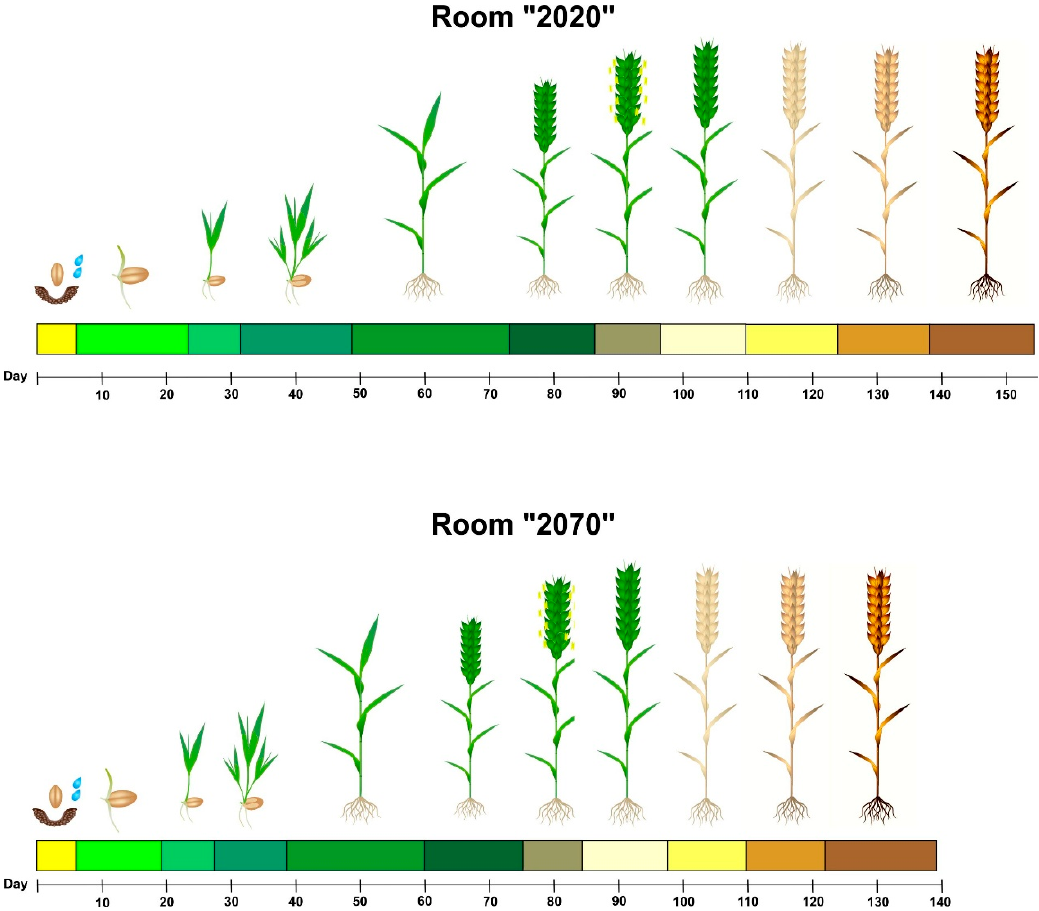
Figure 1. Durum wheat life cycle in the different environmental conditions of rooms “2020” and “2070”. The pictures represent the developmental stages (Planting, Emergence, II leaf, Tillering, Booting, Inflorescence emergence, Flowering, Grain filling “milk stage”, Grain filling “dough stage”, Grain ripening, and Harvest). The number of days after sowing are reported.